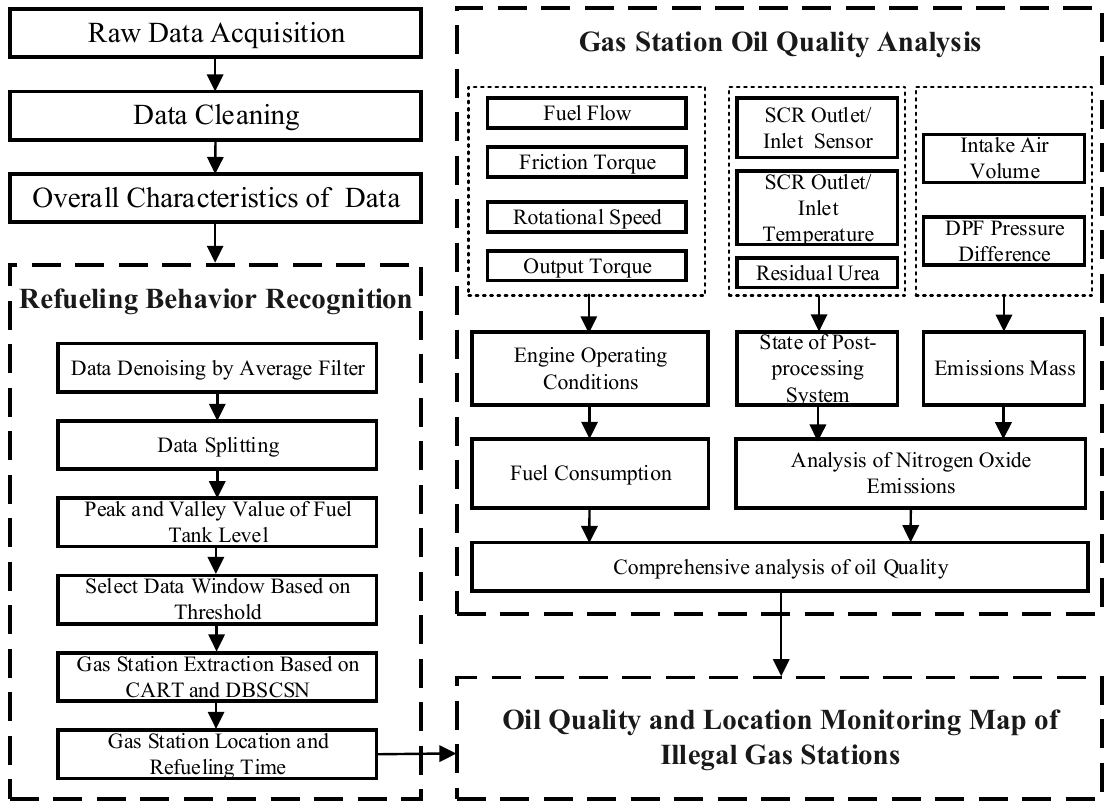
Figure 1. System framework of the gas station recognition and the oil quality analysis.